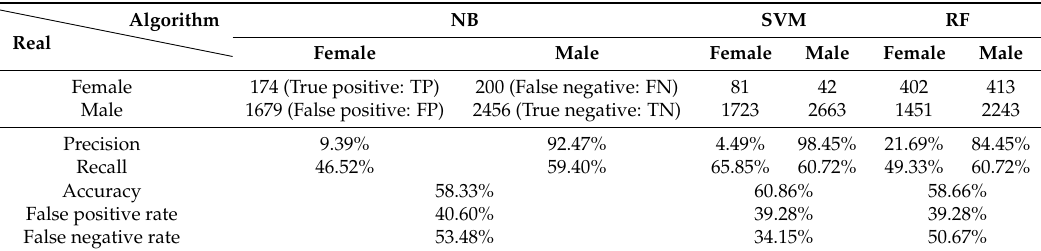
Table 4. The accuracy of gender detection using sentiment feature